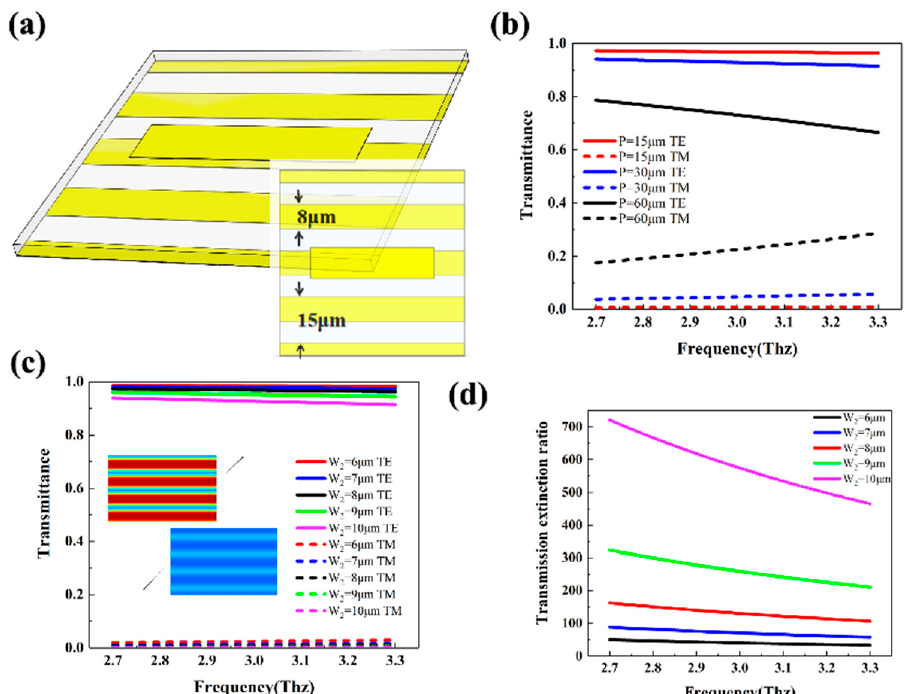
Figure 5. ( a ) Schematic diagram of the composite supersurface structure. The wire grid has a line width of 8 µ m and a period of 15 µ m. ( b ) The effect of grid period on transmissivity. ( c ) The effect of grid width on transmissivity. ( d ) The effect of grid width on extinction ratio.